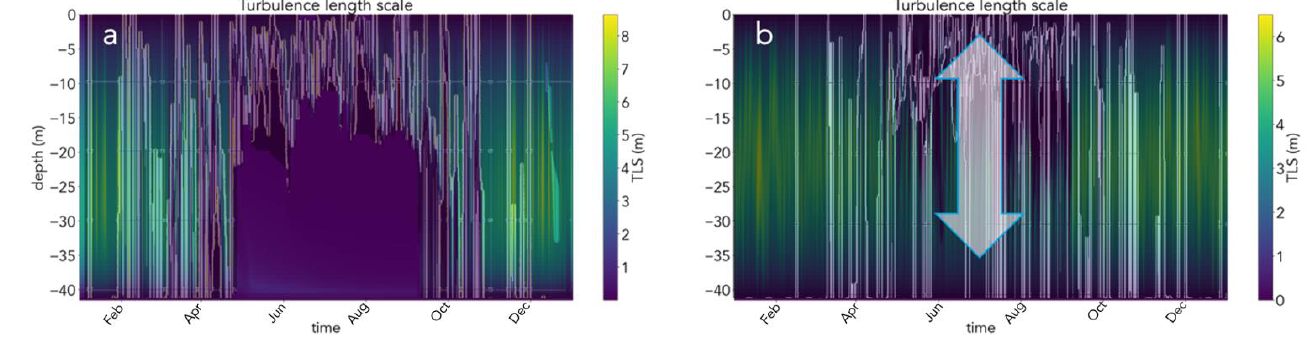
Figure 12. TLS (m) and SML depth in 2 scenarios: ( a ) — without tides, ( b ) — with tides (SML and BML (bottom mixed layer) meet during summer season — water column is permanently mixed).